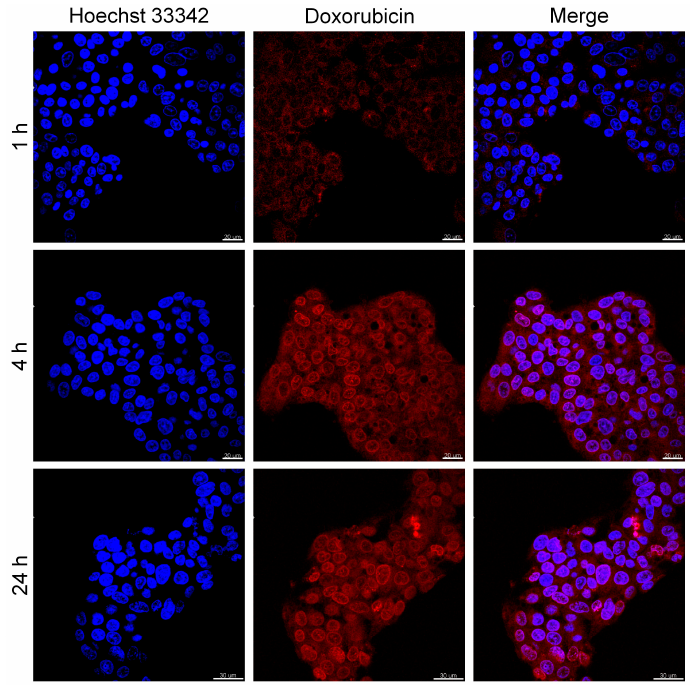
Figure 8. Confocal microscopy images of HepG2 cells incubated with Fe 3 O 4 @PDA@SH- β CD@DOXO at different time points. ( 1st row ) blue-nuclei stained with Hoechst 33342; ( 2nd row ) Red-DOXO fluorescence; ( 3rd row ) represents column one and two combined.